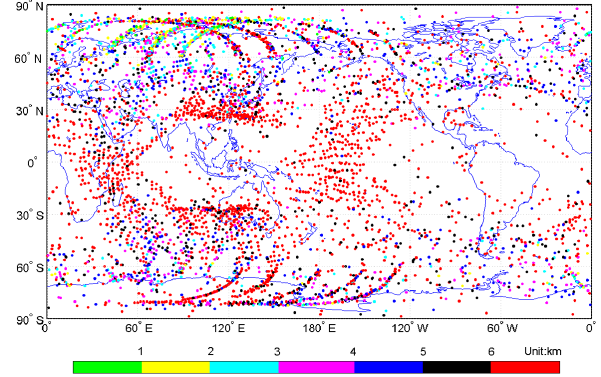
Figure 2. Map of the GNOS BDS occultation coverage from 1 November to 31 December 2013, with a total of 4648 samples. Different colours indicate different penetration depths.